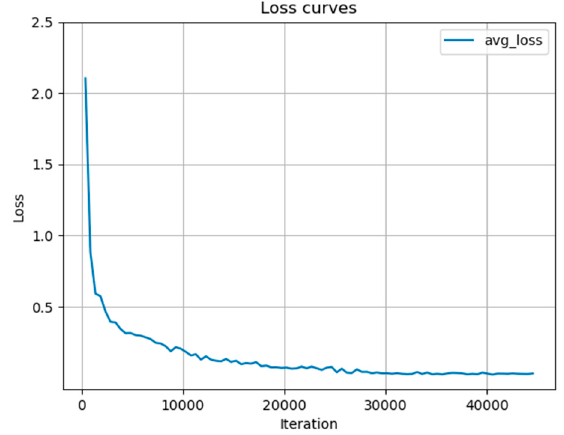
Figure 10. Training results of YOLOv3.